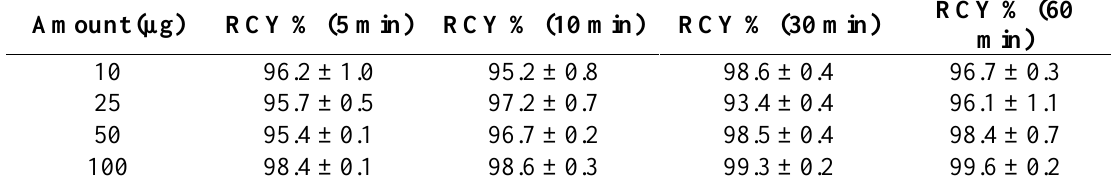
Table 3. Dependence of the RCY of [ 177 Lu]Lu-CHX-A''-DTPA-DUPA-Pep on peptide amount (concentration) and reaction time at room temperature.